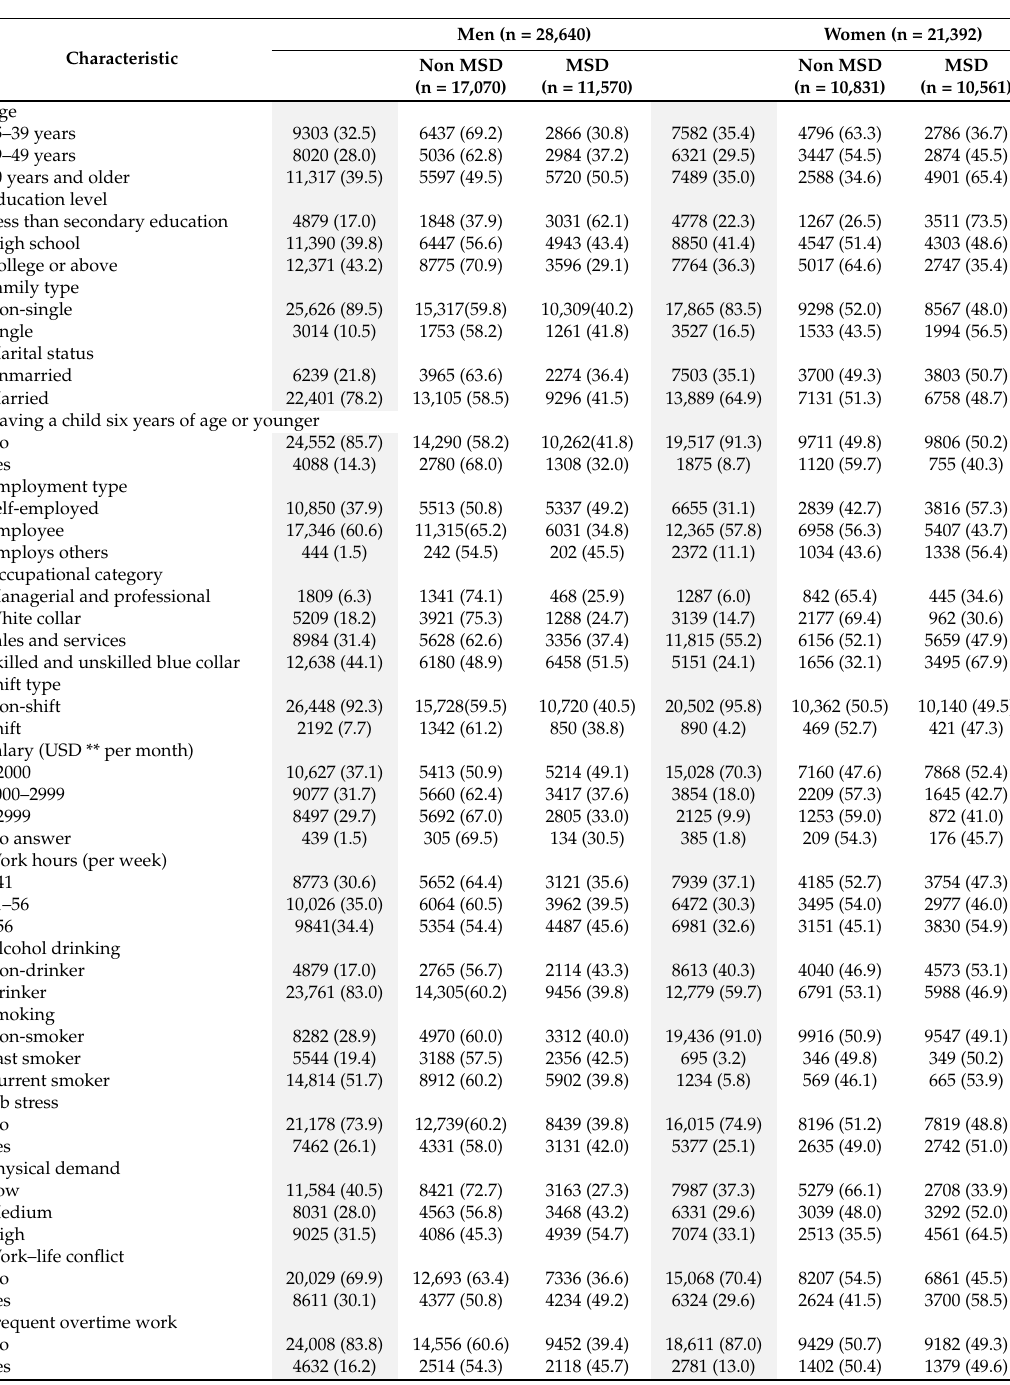
Table 1. Prevalence of musculoskeletal disorders by characteristics of men and women in the study n (%)